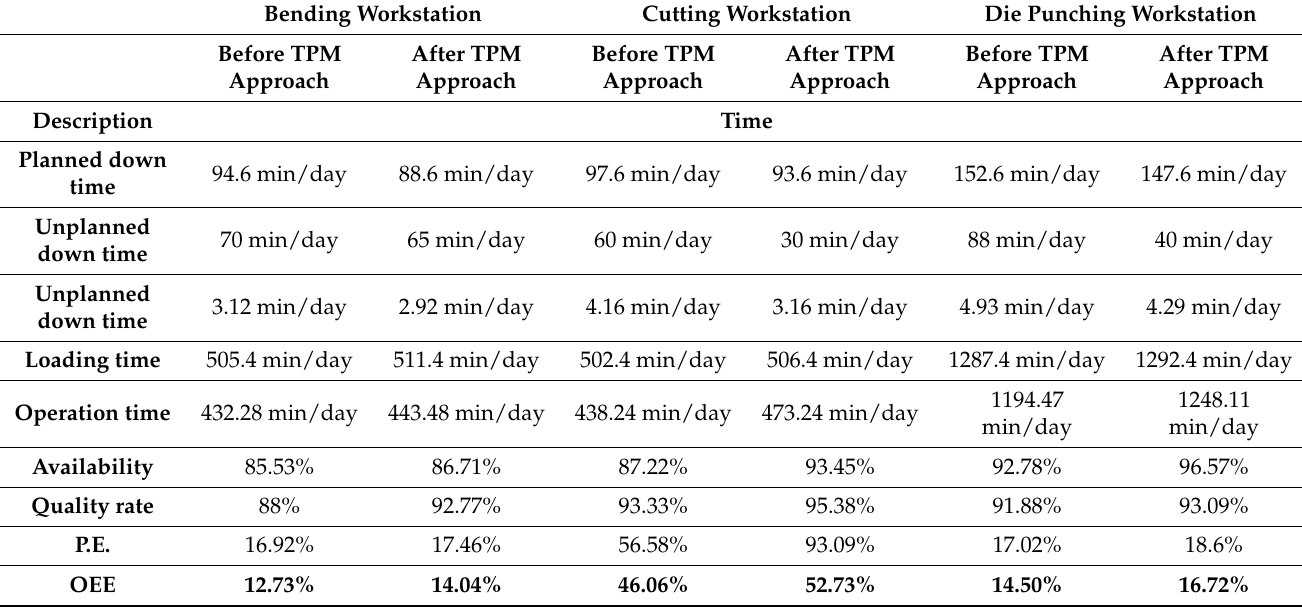
Table 4. Overall equipment efficiency evaluation before/after TPM